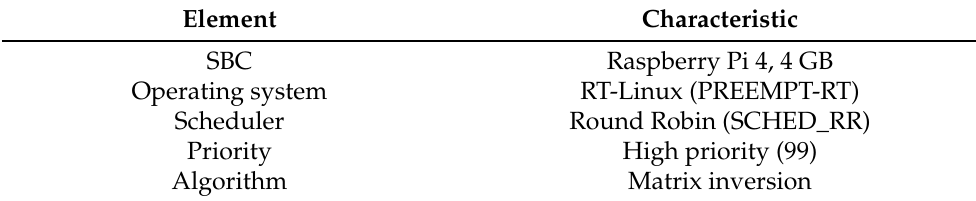
Table 2. Test bench elements and their